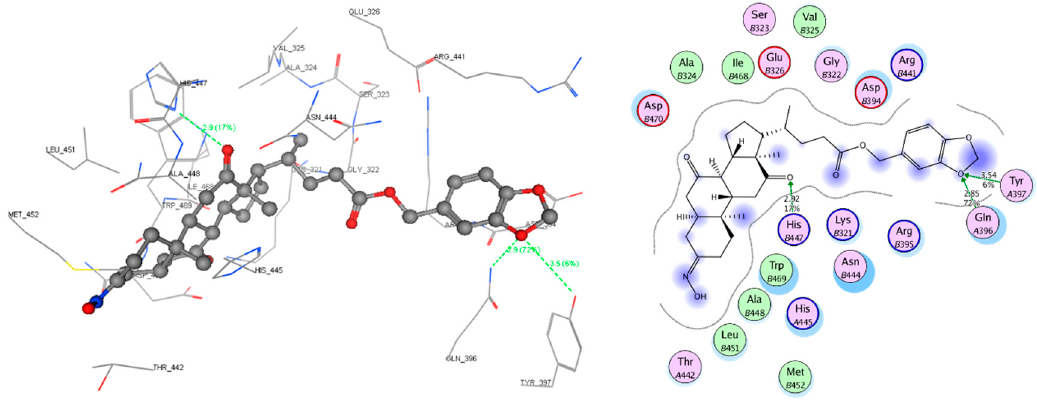
Figure 4. Theoretical Binding mode of compound 2b-3 in bile acid receptor protein (PDB: 3bej) in 3D and two-dimensional (2D).